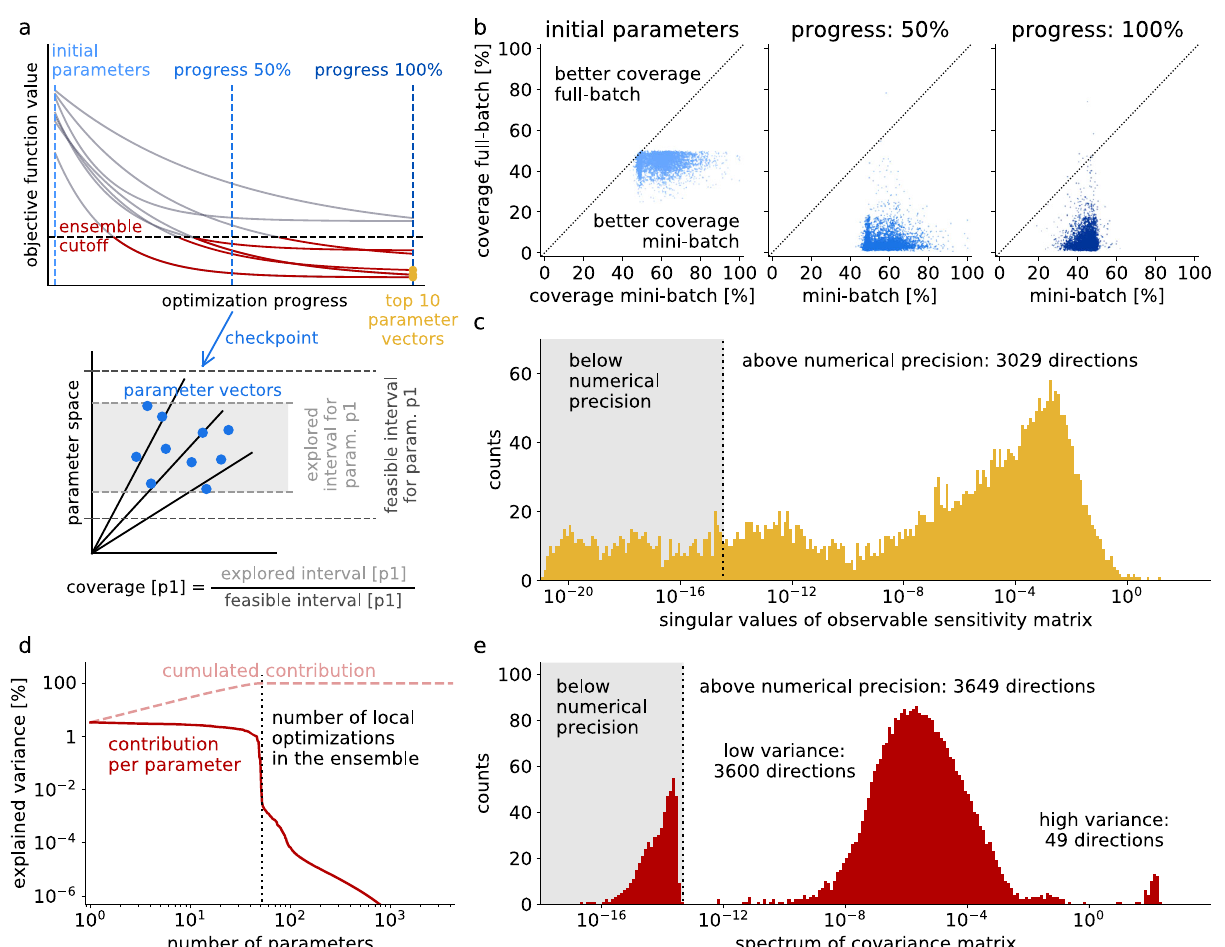
Fig. 7 Analysis of parameter uncertainty based on an ensemble of parameter vectors from the the best mini-batch optimization, i.e., with batch size 10. a Generation of a large parameter ensemble (8,450 vectors) based on the history of multi-start local mini-batch optimization. A cutoff value was chosen and parameter vectors added to the ensemble if the objective function value was below the cutoff (red). A smaller ensemble was created from the ten best optimization results (yellow). At three checkpoints (blue), the coverage of parameter intervals was computed as a ratio of the interval covered by the optimization runs over the interval between the parameter bounds. b Computation of parameter interval coverage based on multi-start local optimization with mini-batch optimization and Ipopt (full-batch optimization). c Sensitivity analysis for model output (cell viability) w.r.t. the 4232 model parameters. Singular values of the sensitivity matrix computed on the small parameter ensemble. d Principal component analysis of the large parameter ensemble created from mini-batch optimization, indicating the contribution (individual and summed) of the different PCA directions to the total observed variance in the ensemble. e Spectrum of the covariance matrix (for the 4232 model parameters) created from the large parameter ensemble from ( d